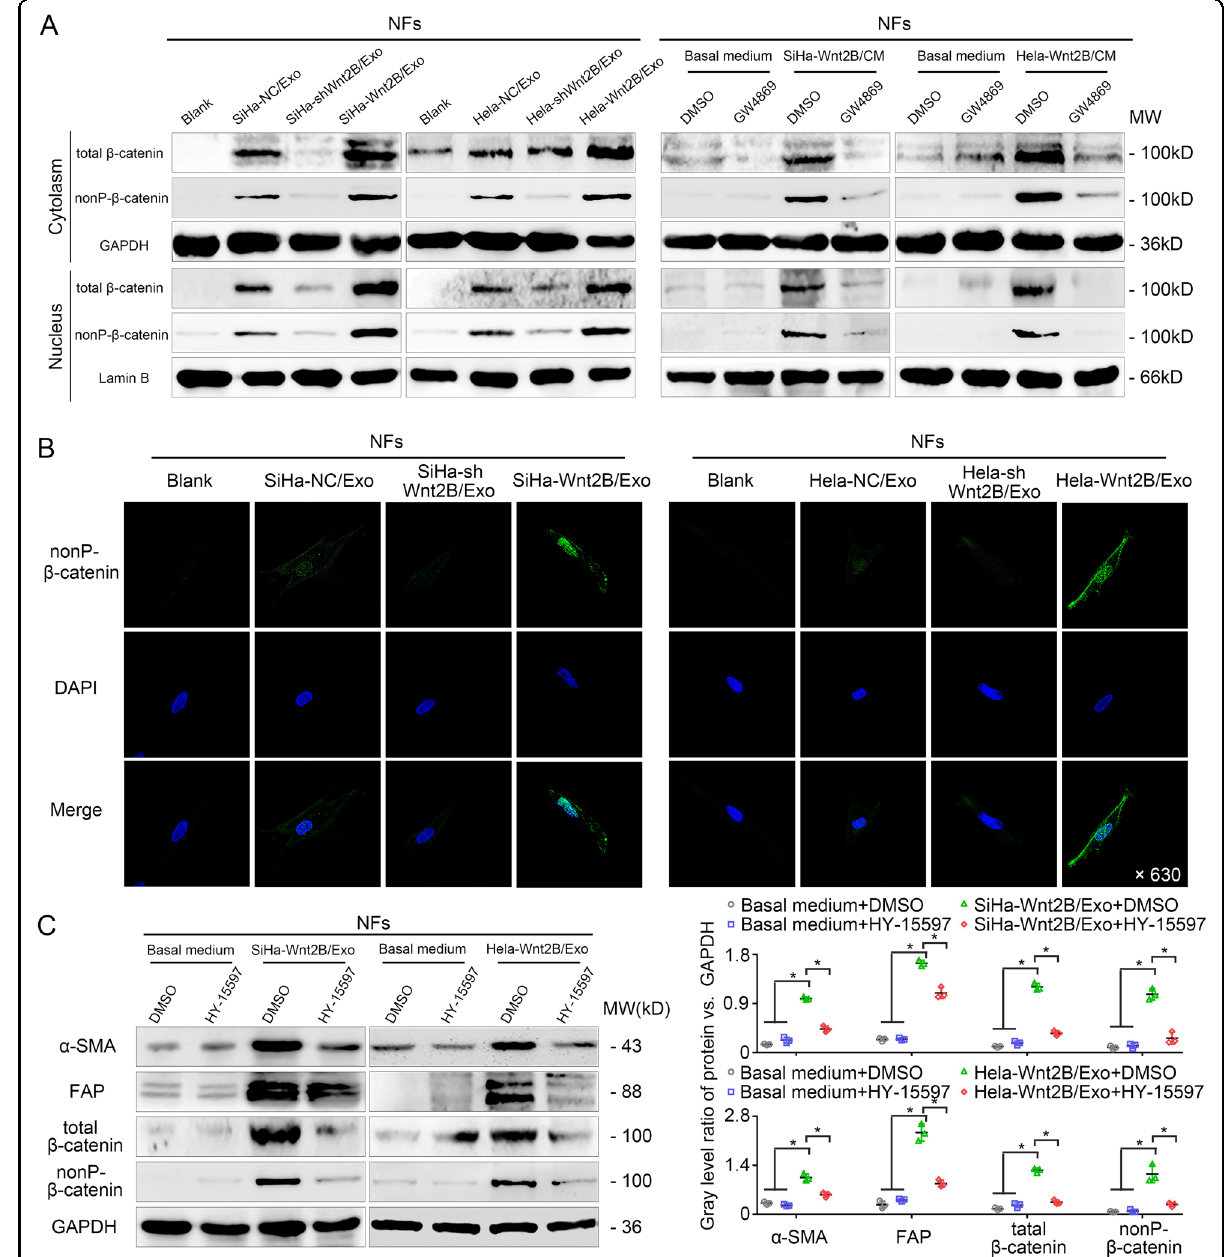
Fig. 5 Wnt2B-driven CAF conversion depends on Wnt/ β -catenin signaling. A Western blot analysis for Wnt/ β -catenin signaling activation by total and non-phosphorylated (nonP) β -catenin (Ser33/37/Thr41) expression and localization in NFs cultured alone (blank group) or co-cultured with the exosomes (left). Western blot analysis for activation of Wnt/ β -catenin signaling by total and nonP- β -catenin (Ser33/37/Thr41) expression and localization in NFs pre-treated with CM from SiHa-Wnt2B and Hela-Wnt2B cells treated with DMSO or GW4869, while NFs treated with DMSO or GW4869 in the basal medium were used as the control group (right). GAPDH was used as a loading control for cytoplasmic proteins, and laminin B as a loading control for nuclear proteins. B Immuno fl uorescence analysis of nonP- β -catenin (Ser33/37/Thr41) (green) localization in fi broblasts treated as indicated. Representative images are shown at ×630 magni fi cation. C Immunoblot assays for CAF markers, total and nonP- β -catenin (Ser33/37/Thr41), in fi broblasts treated with exosomes and incubated with DMSO or HY-15597 (10 μ M) for 1 day. Right: line graph showing the changes (indicated in gray) in the ratio of proteins to GAPDH described on the left. Error bars represent the mean ± SD of three independent experiments. * P < 0.05.